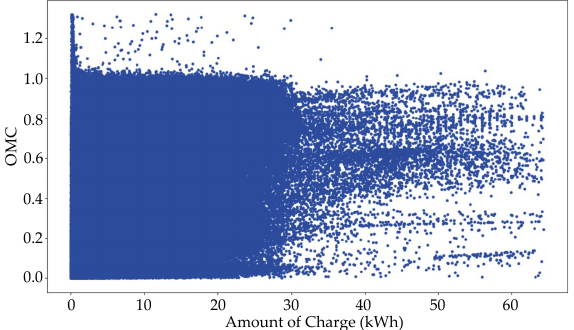
Figure 3. Refined data after removing the